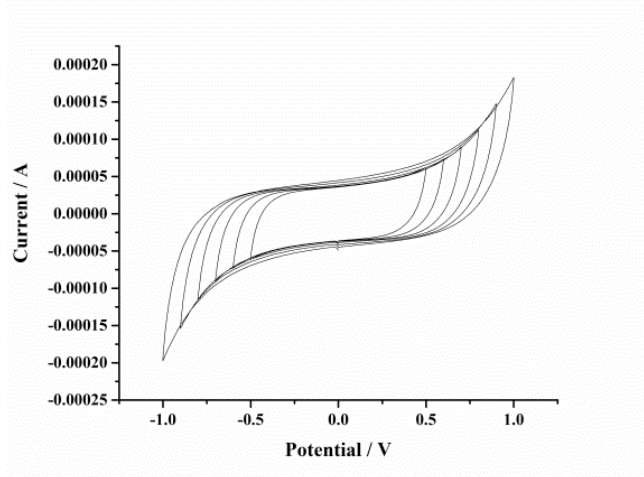
Figure 4: Cyclic Voltammograms obtained for the EDLC for different potential windows.